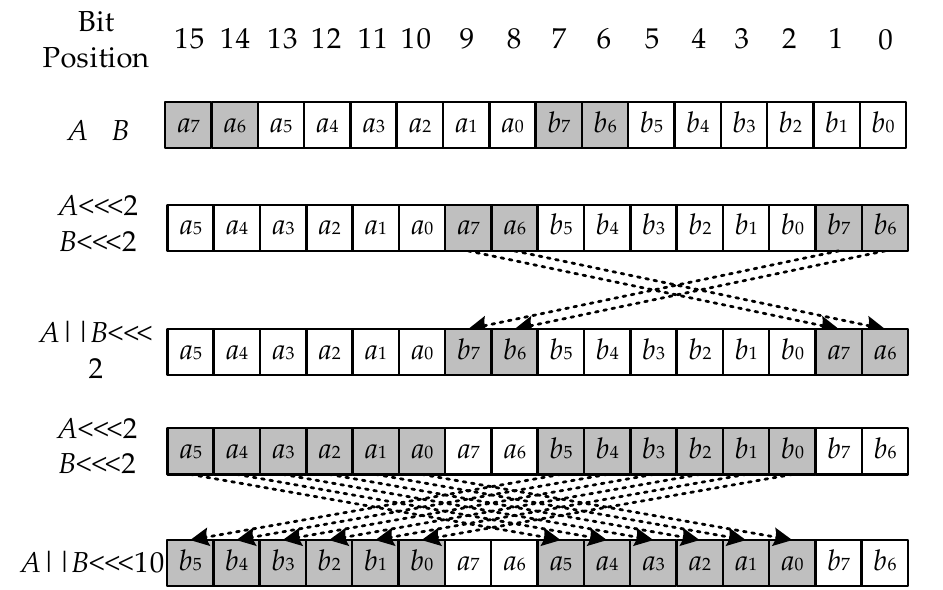
Figure 1. Implementation principles of N -bit shift transformation based on N /2-bit rotation and interchanging operations.